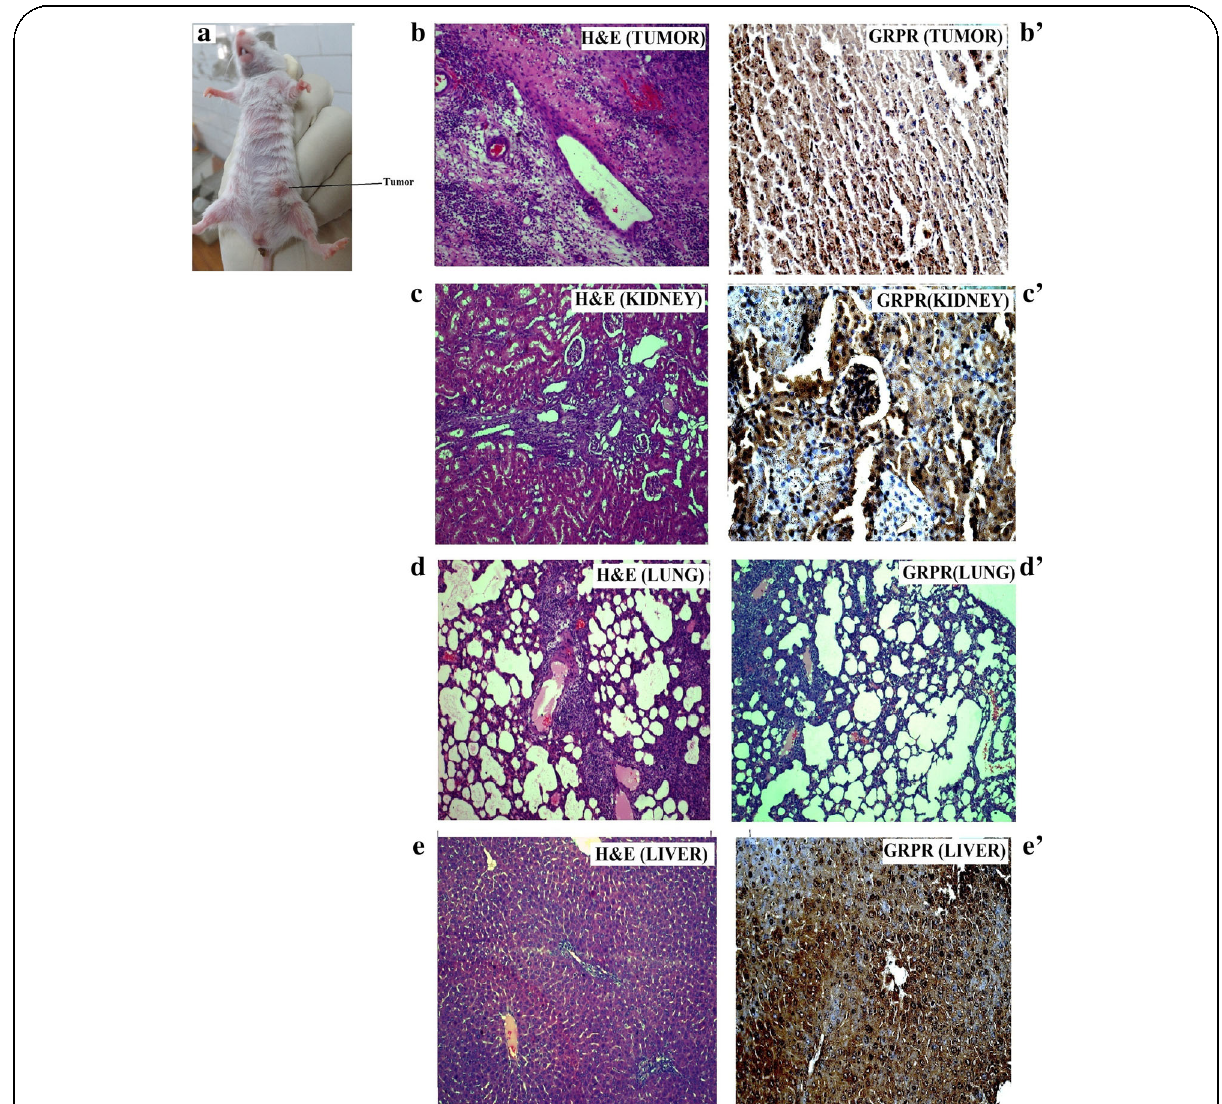
Fig. 7 Histological and immunohistochemical micrographs of MDA-MB-231 cells induced mice tumor. ( a ) H&E staining of mice tumor section ( b ) and kidney section, ( c ) lung section, ( d ) liver section, and ( e ) excised from tumor-bearing mice and IHC staining for GRPR expression in mice tumor section ( b ′ ) and kidney section ( c ′ ), lung section ( d ′ ), and liver section ( e ′ ) of metastases tumor-bearing